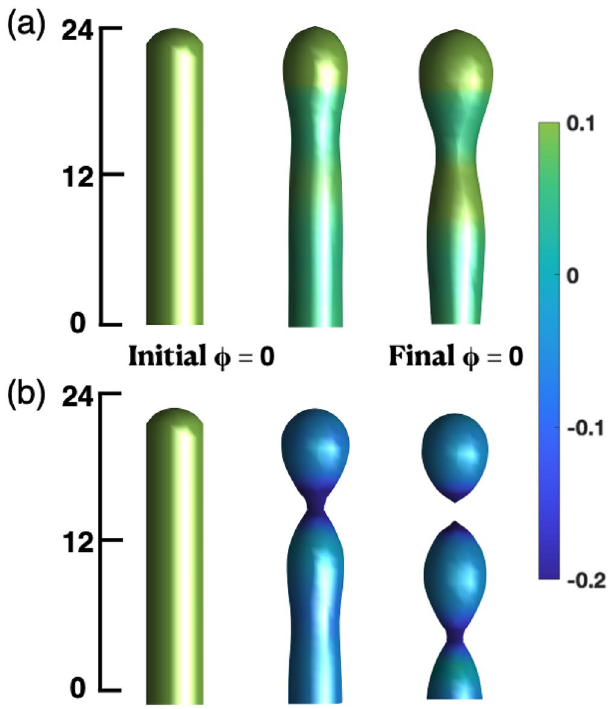
0 ). 0 without considering Gaussian curvature ( κ ′ = = 10 . The snapshots are taken at the same time = − 0 is taken after solving Eq. κ . The initial condition for φ ¯ = 5 and L 26 in units of the domain grid and, ε 1 , κ 1 , = = = =